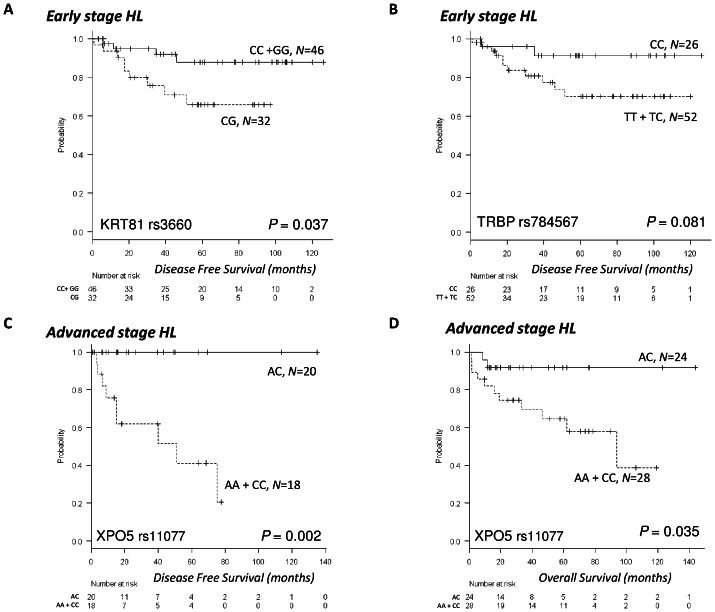
Clinical outcomes in early and advanced HL according to miR-SNPs. DFS in early-stage HL patients according to KRT81 and TRBP and in advanced HL patients according to XPO5. And OS in advanced-stage HL patients according to XPO5. (A) DFS was 72.3 months (95% CI, 59–86) for patients with the KRT81 CG genotype and 114.3 months (95% CI, 103–125) for those with the TT or TC genotype (P = 0.037). (B) A trend towards an association between the TRBP genotype and DFS in early-stage patients was also observed; mean DFS was 117 months (95% CI, 105–129) for patients with the TT genotype, compared to 92 months (95% CI, 78–106) for those with the CC or TC genotype (P = 0.081). (C) All patients with the XPO5 AC genotype were disease-free at the time of this analysis, while mean DFS among patients with the AA or CC genotype was 30.9 months (95% CI, 18–44) (P = 0.002). (D) OS was 133 months (95% CI, 118–148) in patients harboring the AC genotype compared to 74 months (95% CI, 55–94) for those with the AA or CC genotype (P = 0.035).